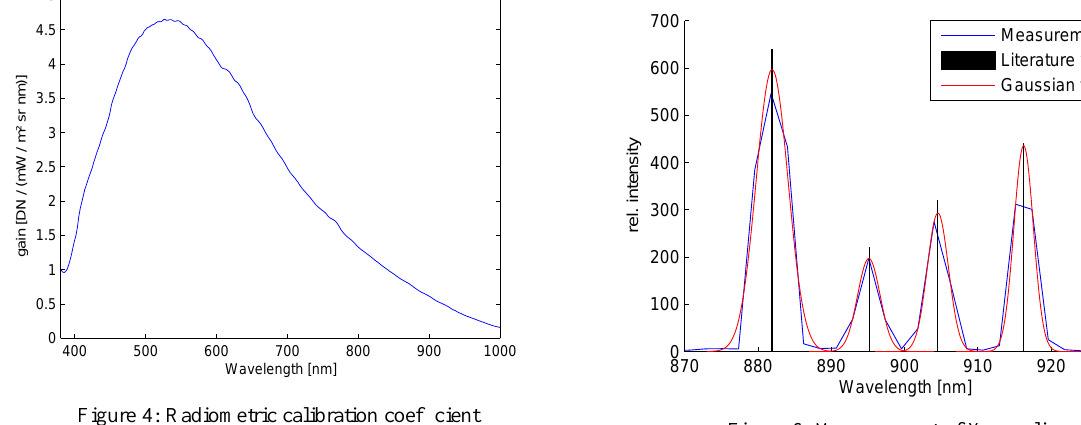
Figure 6: Measurement of Xenon lines